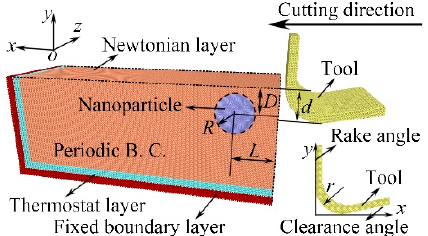
Figure 1. Nano-cutting molecular dynamics (MD) simulation model with a nanoparticle.